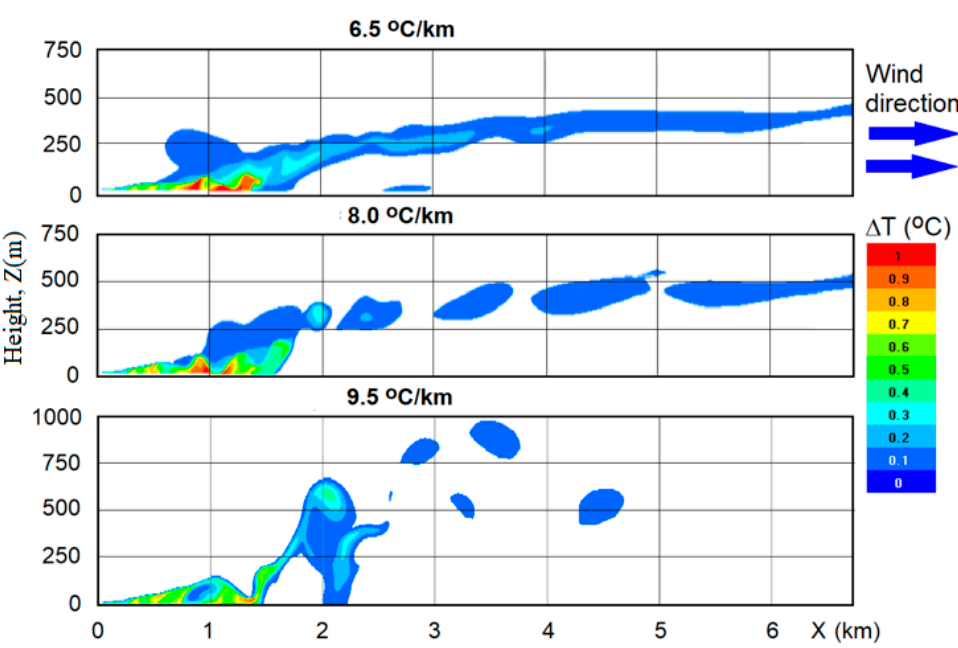
Figure 11. Thermal convection triggered by artificial aerosol layer with S = 1 km 2 in atmosphere with wind speed U = 1 + 0.005 Z and TLR = 6.5, 8.0 and 9.5 °C/km.